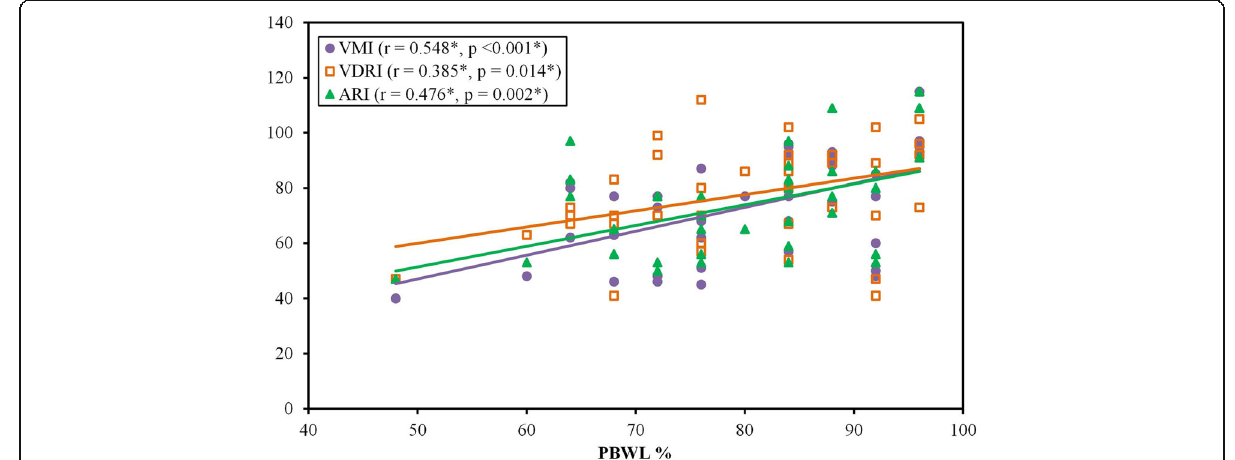
Fig. 4 Scatter diagram and best fit lines for the correlation between PBWL scores and TOMAL-2 indices